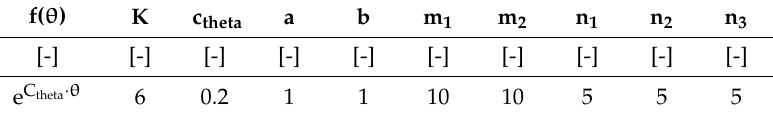
Table 1. Gielis’ parameters used in Equation (1) to generate the Spiral shell DRA.